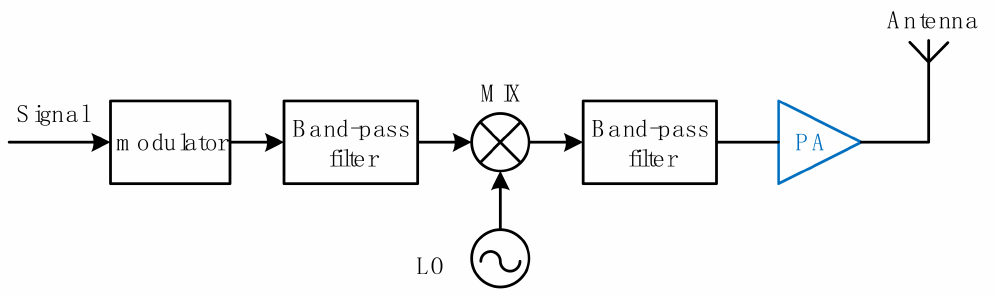
Figure 1. A block diagram of a communication system